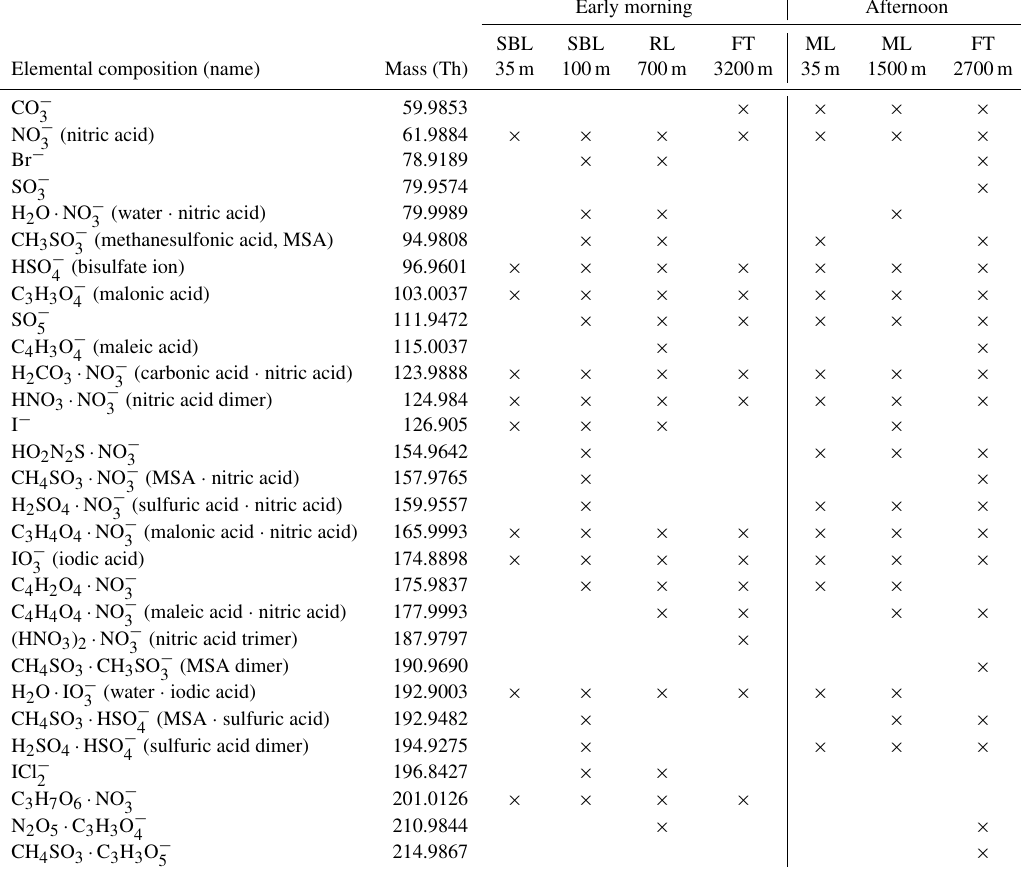
Table A1. Identified compounds of the stable boundary layer (SBL), residual layer (RL), free troposphere (FT), and mixed layer (ML) on 2 May 2017 at different heights during early morning and afternoon flight. The mass is given as the measured mass of the most abundant